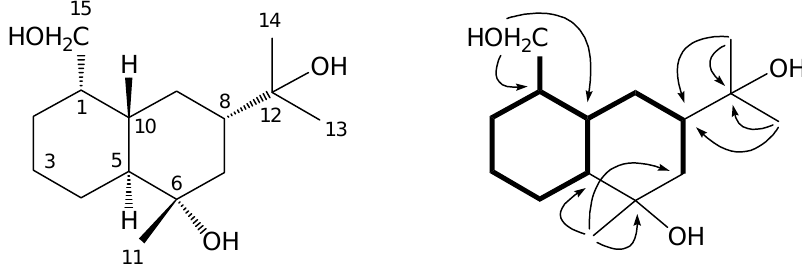
Figure 1. Structure, key H- 1 H COSY ( ─ ) and HMBC correlations (H → C) of compound 1 . HOH 2